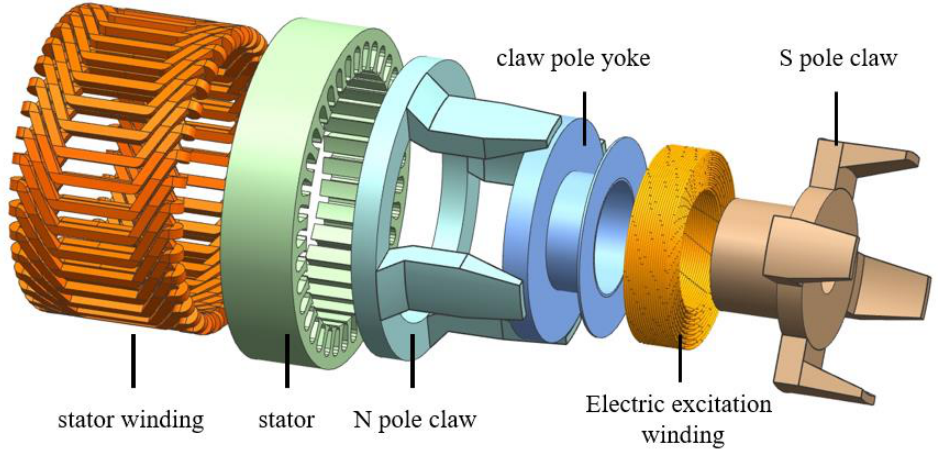
Figure 1. Structure diagram of reverse brushless claw-pole generator.